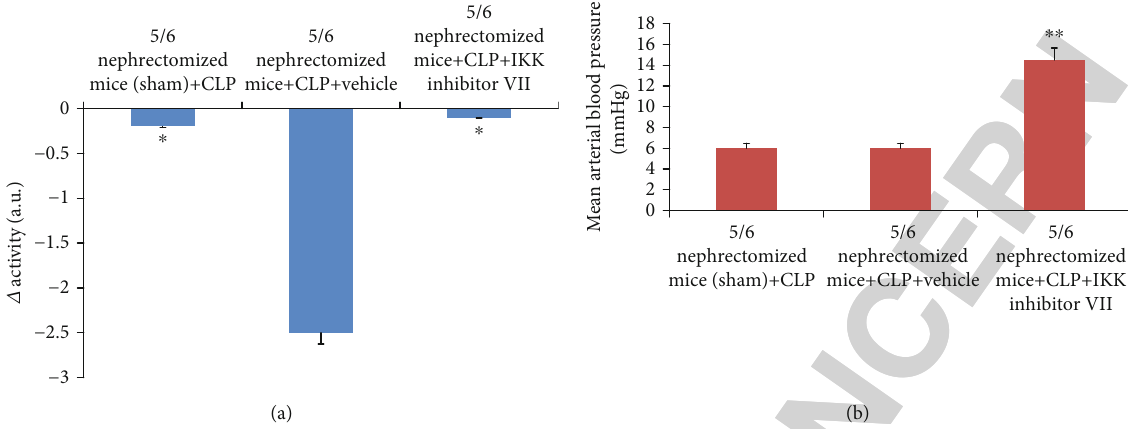
Figure 2: Treatment of IKK inhibitor VII or CLP causes a notable change in activity, but a small change in MABP in 5/6 nephrectomized mice. Radiotelemetric study of (a) delta activity. (b) MABP in conscious condition of 5/6 nephrectomized sham (black mice) or 5/6 nephrectomized sham mice (white and red) subjected to CLP. After 60 minutes of CLP, 5/6 nephrectomized mice were injected with PBS (black) or IKK inhibitor VII. The results are presented as means ± SEM . ∗ P < 0 : 05 compared to 5/6 nephrectomized, CLP, and PBS-treated